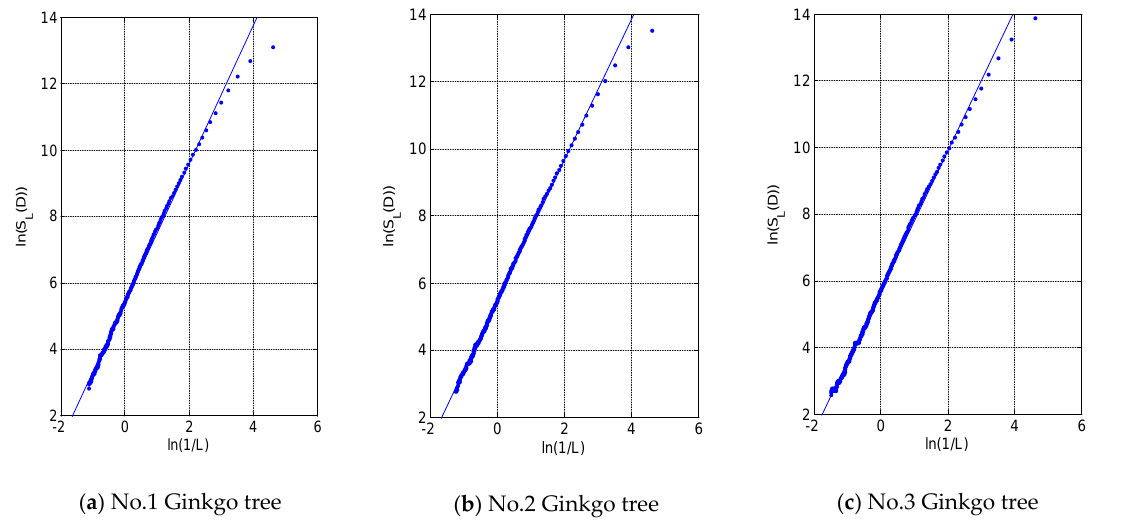
Figure 6. Double logarithmic scatter plots of three Ginkgo trees with foliage. Table 1. Fractal dimensions calculation results of Ginkgo trees with foliage.